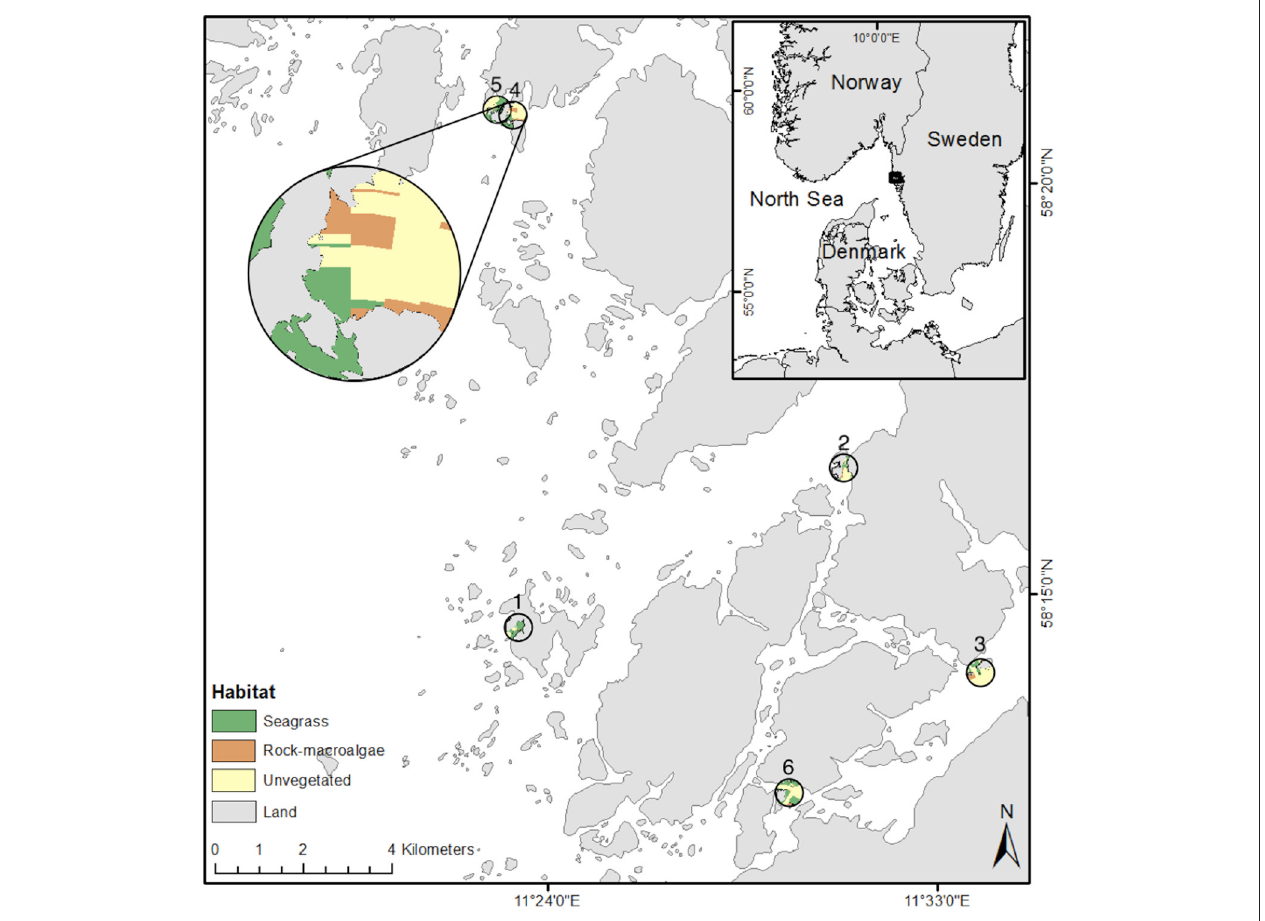
FIGURE 1 | Map of all six seascapes where cameras were placed. The map shows a zoomed image (top left) of one site where habitat locations within the seascape are visible. Site locations are numbered. Coastline: © Lantmäteriet I2016/00691.